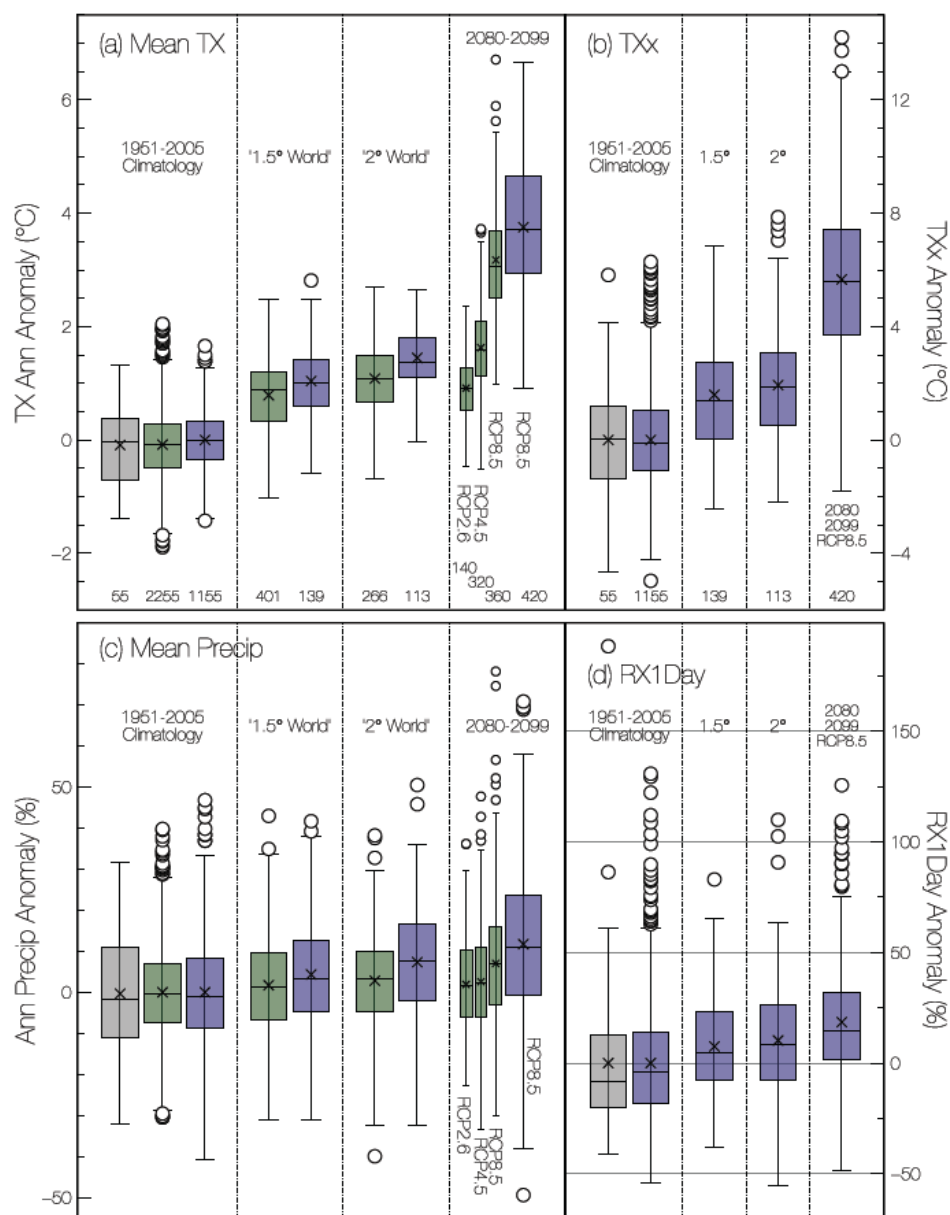
Figure 6. Histograms of WP station data (grey shading), CORDEX (green shading) and NEX (blue shading) climate model output for: ( a , b ) annual mean TX and TXx; and ( c , d ) annual total precipitation and RX1Day. All data are presented as anomalies (per cent for precipitation) relative to the 1951–2005 mean for each index (station mean data for WP, an individual model data for CORDEX/NEX). Numbers along the upper x-axis indicate the number of available years of data contributing to each histogram. Four time periods are analysed: the historical/base period 1951–2005, model results from when global temperatures are in a 1.5/2 °C world (defined in the main text) and for the end of 21st century period 2080–2099. The 2080–2099 CORDEX box plots are split via RCP scenarios. An alternative version of this figure showing absolute magnitudes is in the supplementary material.